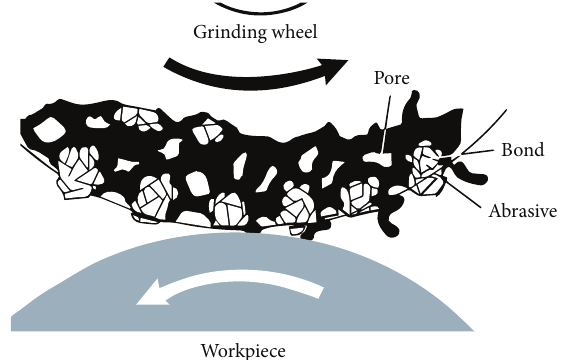
Figure 1: Basic principles of grinding.